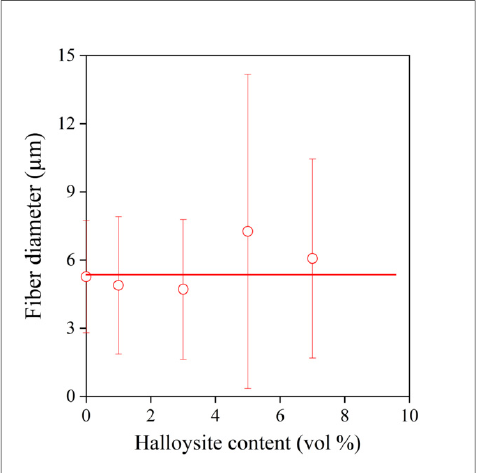
Figure 9. Effect of electrospinning on the distribution of halloysite nanotubes and the structure of the fibers prepared from PCL/halloysite composite materials. Halloysite content and magnification: ( a ) 3 vol%, 2000×; ( b ) 3 vol% 5000×; ( c ) 5 vol%, 5000×.